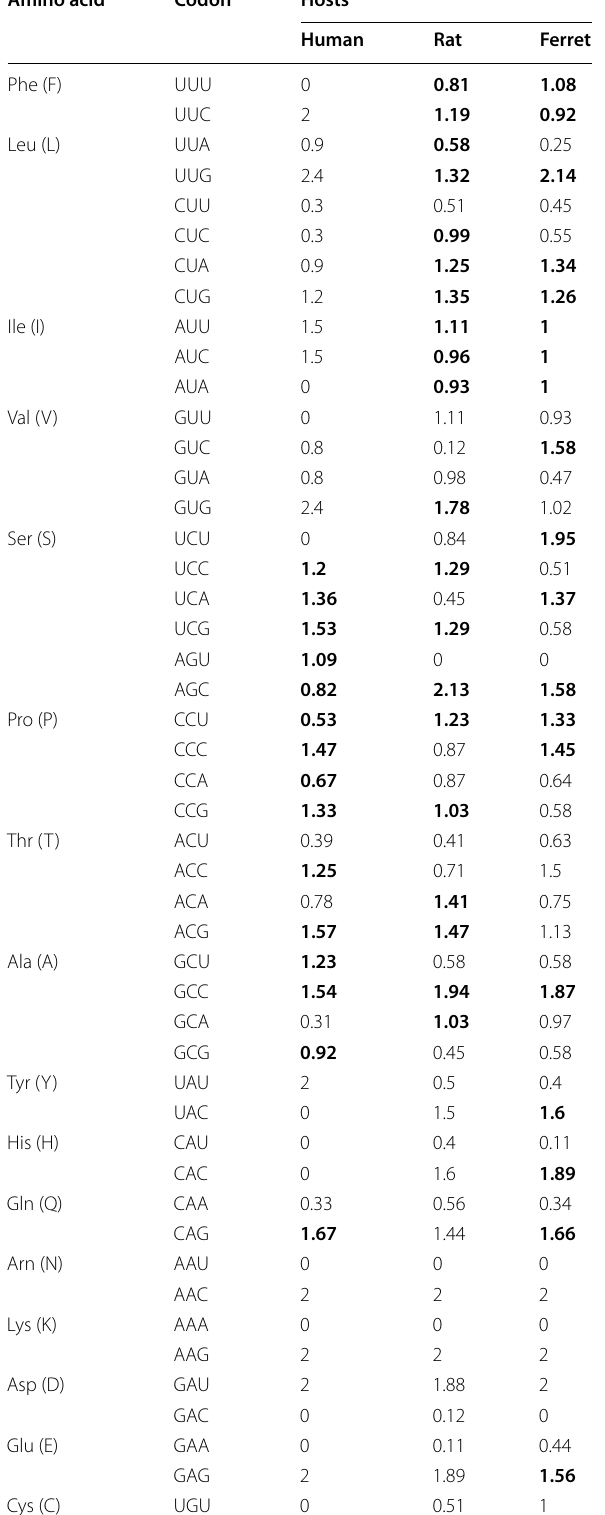
Table 2 Average RSCU values in ORF4 of hepatitis E